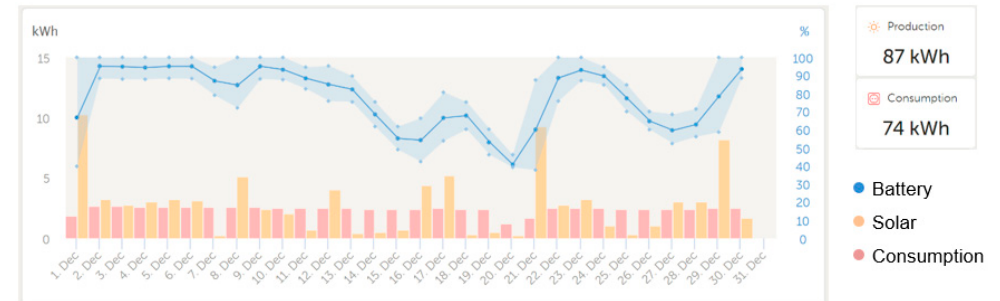
Figure 19. Energy analysis report of the LSF module during December 2020.